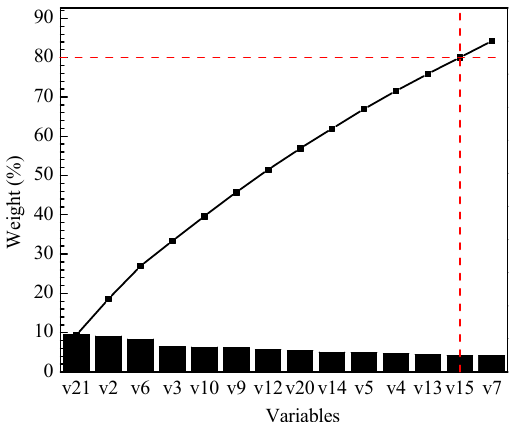
Figure 6. Weight of the key measurement variables for fault 4.